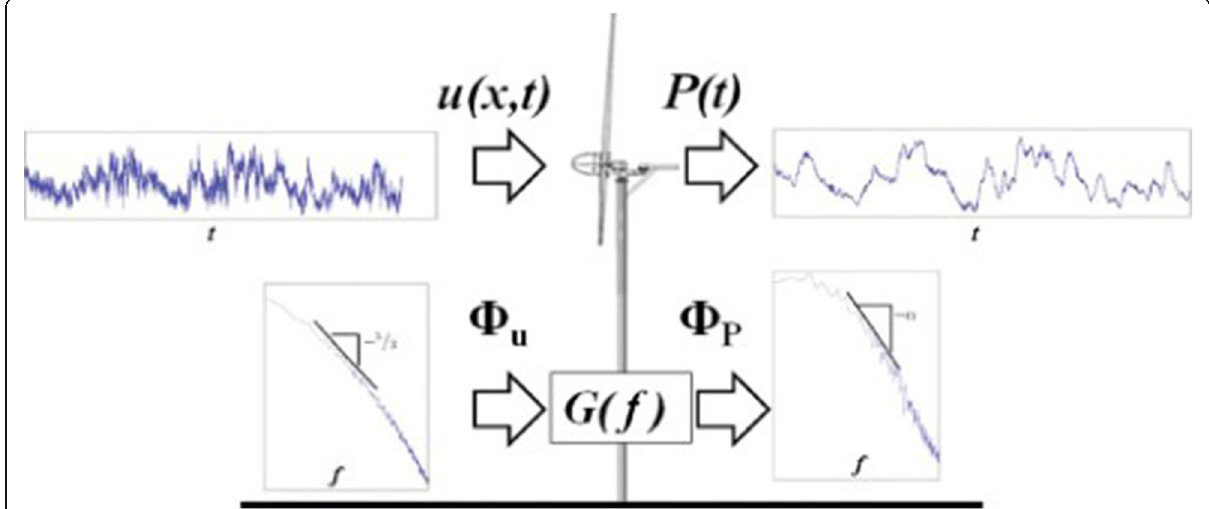
Fig. 6 Schematic of the wind turbine energy conversion process